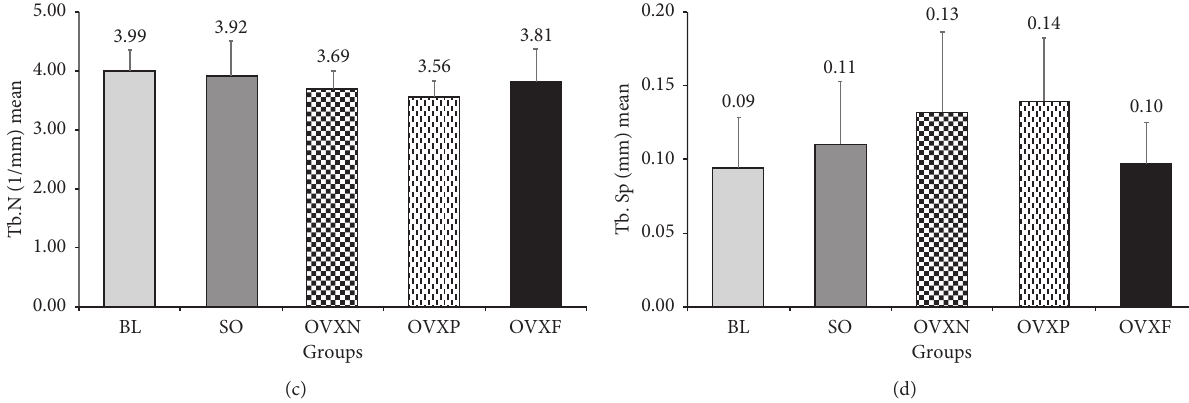
Figure 6: Parameters obtained based on the micro-CTmeasurements. Mean and standard deviation of (a) bone volume trabecular (BV/TV), (b) trabecular bone thickness (Tb.Th), (c) trabecular bone number (Tb.N), and (d) trabecular bone separation (Tb.Sp) among